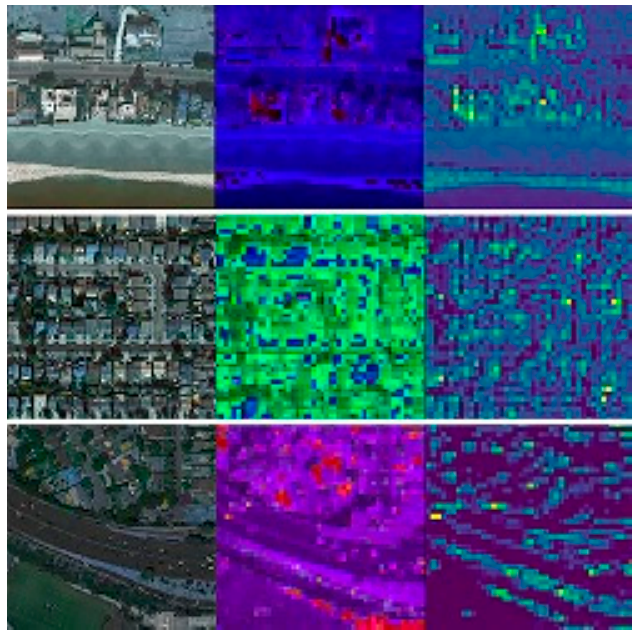
Figure 1. Visualization of features from the activation maps from the first and second residual blocks of ResNet50.